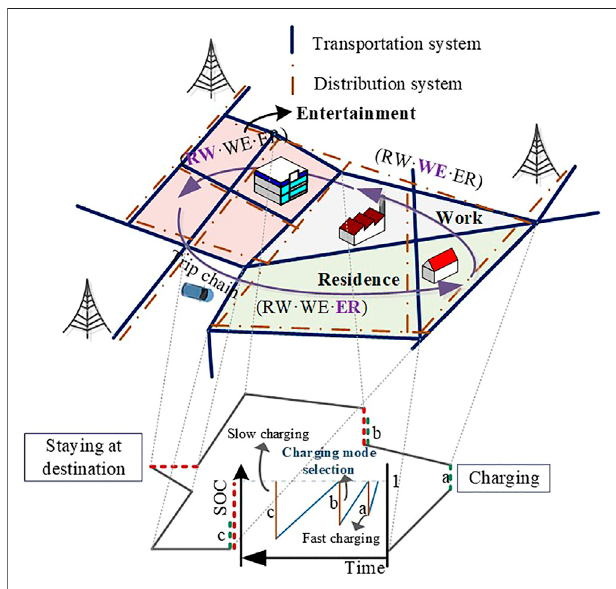
FIGURE 2 | Coupled system framework based spatial-temporal mobile EV